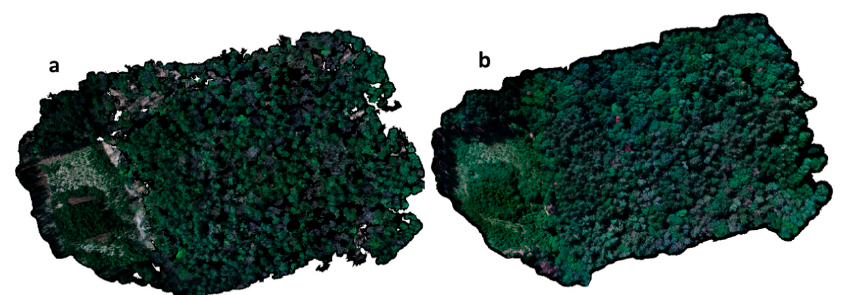
Figure 3. Illustration of the resultant forest models. UAS orthophotos in RGB from both seasonal datasets; ( a ) spring 2019 and ( b ) summer 2019.